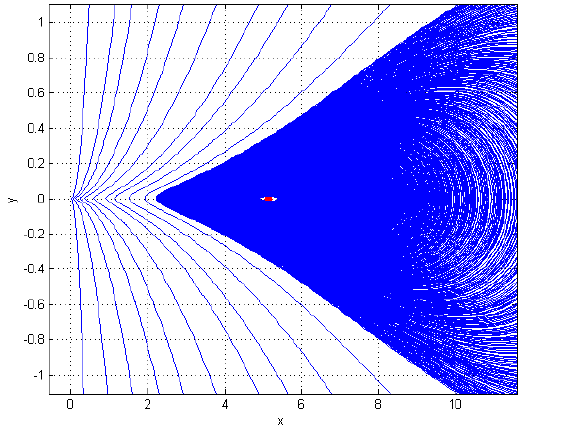
Fig. 2. Phase plane trajectory diagram, where traveling wave velocity c=-6.7, traveling wave parameter